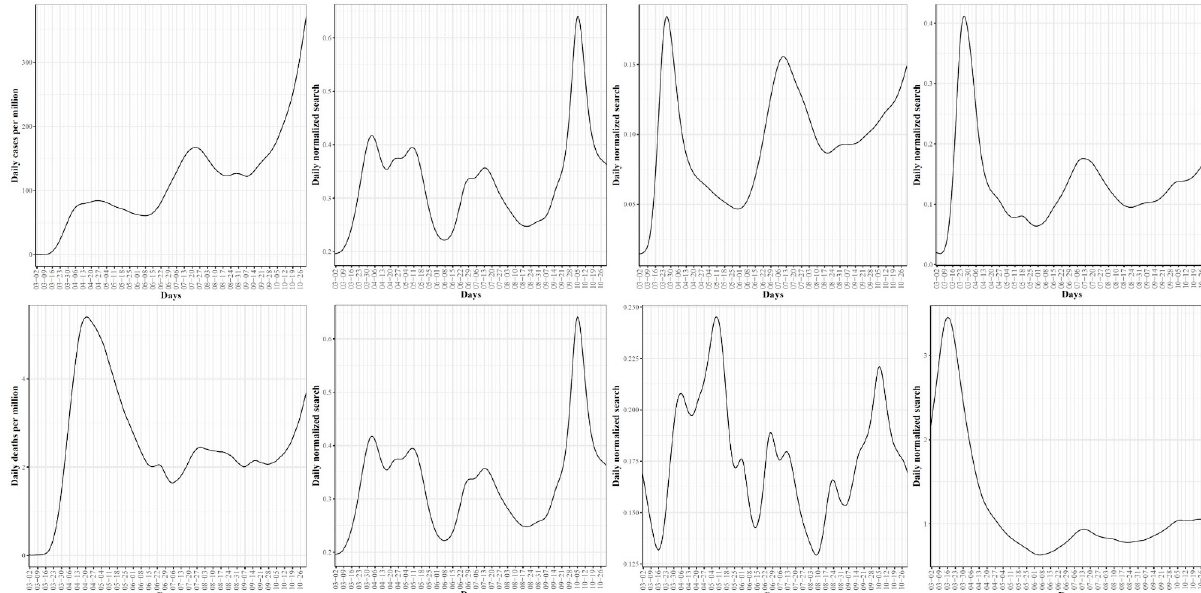
Figure 13. At the top are the mean curves for the COVID-19 confirmed cases, hypoxemia, ageusia, and anosmia searches, respectively. At the bottom are the mean curves for the COVID-19 death cases, hypoxemia, hypoxia, and pneumonia searches,